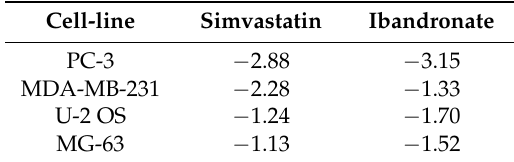
Table 1. Fold downregulation of DNA polymerase A1 ( POLA1